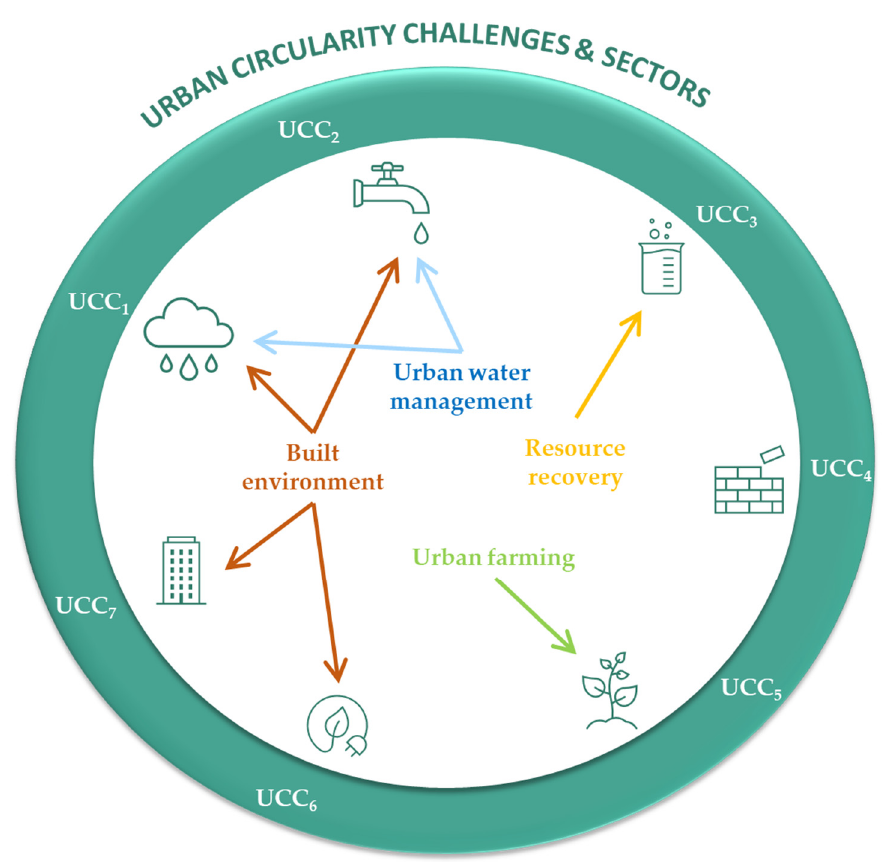
Figure 2. Most relevant Urban Circularity Challenges (UCCs) defined by the urban sectors for selecting relevant nature-based solution units and interventions (NBS_u/i). The arrows highlight the focus of the discussions in the urban sectors. Urban Circularity Challenges: UCC 1 = restoring and maintaining the water cycle; UCC 2 = water and waste treatment, recovery, and reuse; UCC 3 = nutrient recovery and reuse; UCC 4 = material recovery and reuse; UCC 5 = food and biomass production; UCC 6 = energy efficiency and recovery; UCC 7 = building system recovery.